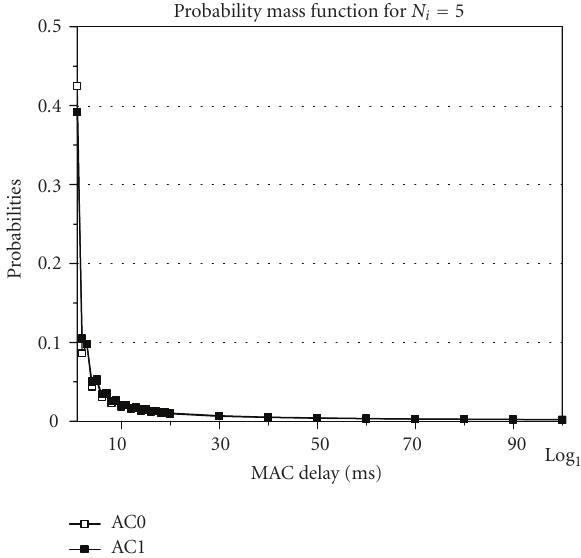
Figure 11: Probability mass function (PMF) for basic access mode and for both ACs. The transmission rate is at 11 Mbps 802.11b/e and the graphs are for 5 numbers of states at each AC[ i